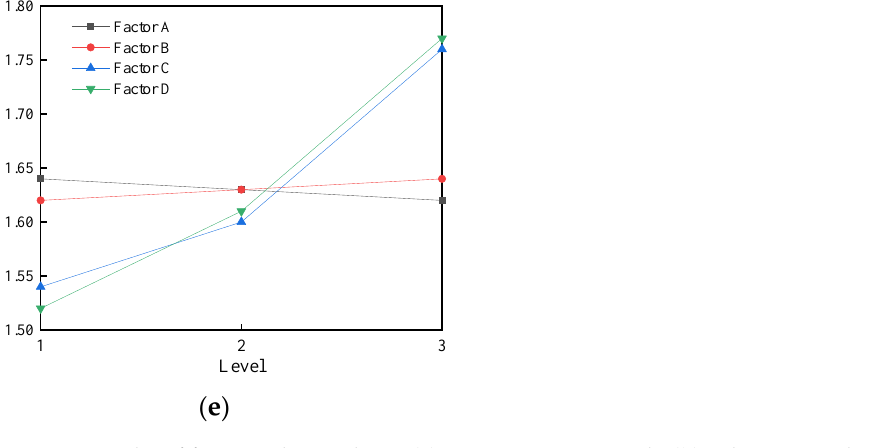
Figure 11. Results of factor index analysis. ( a ) compressive strength; ( b ) splitting tensile strength; ( c ) flexural strength; ( d ) energy dissipation coefficient; ( e ) ductility.